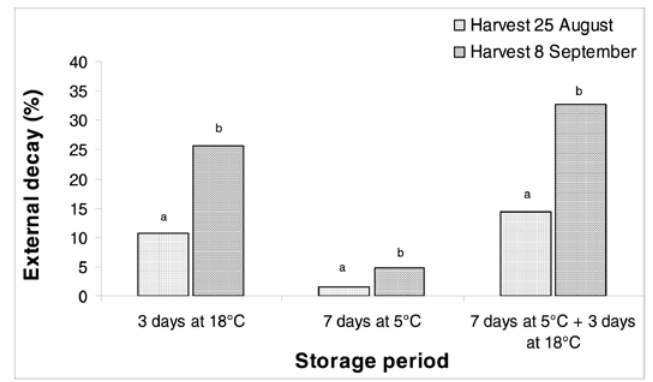
difference.Fig. Fig. 2 - Influence of picking date and storage conditions on internal decay incidence in second crop production of Verde, San Pietro, Perdin- giana and Carcanzi Trota figs. For each storage period histograms with different letters are significantly different, P Table 1 - Influence of 30-s-dip treatments with azoxystrobin (AZO) at 20°C on external and internal decay incidence in second crop ‘Verde’ figs after three days at 18°C and 65% RH, or for seven (z) For each storage period and harvesting time values in columns fol- lowed by different letters are significantly different at P≤0.05 accord- ing to Fisher’s test of the least significant